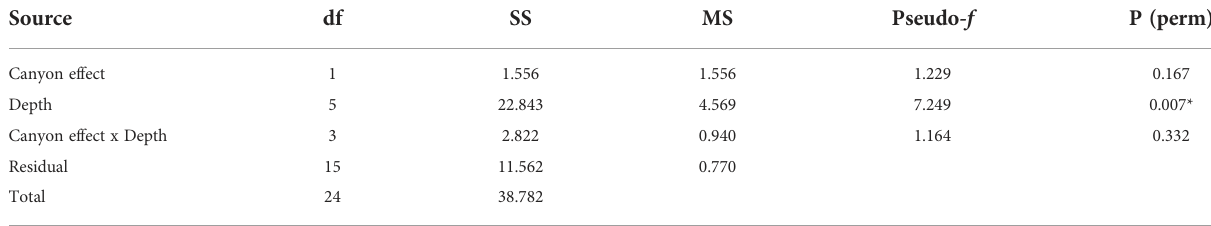
TABLE 2 PERMANOVA, Type1 (sequential) fi xed effects on a permutation of residuals under a reduced model (9999 number of permutations), results of diversity measures in depth zones represented in the canyon and non-canyon stations - where * shows signi fi cant values. Source df SS MS Pseudo- f P